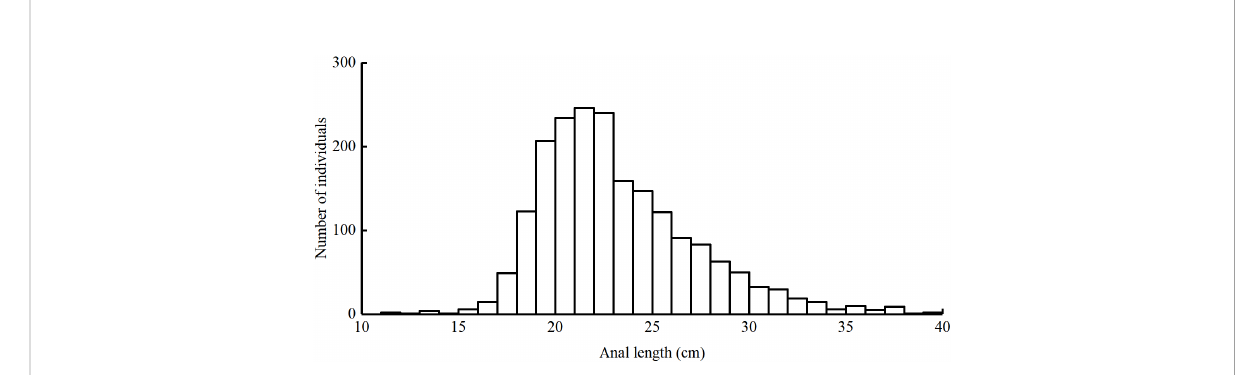
FIGURE 2 Length frequencies of T. lepturus in the the East China Sea specimens captured between 2016 and